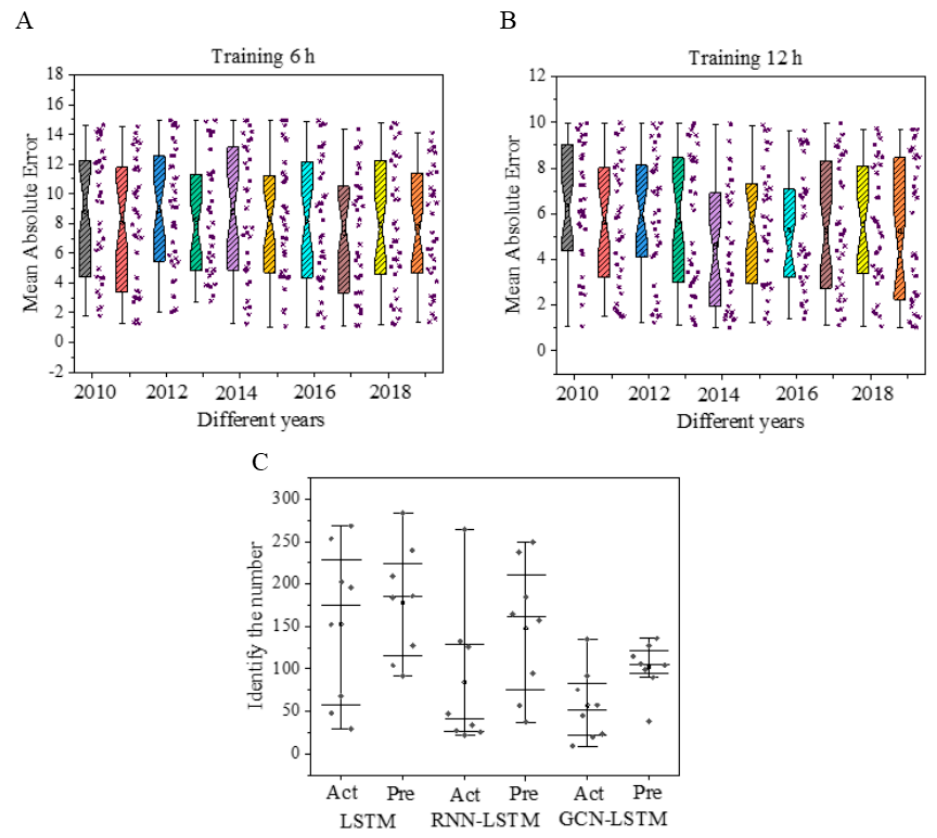
Figure 13. Model stability test results. Figure ( A , B ) illustrate the mean absolute errors of the GCN-LSTM model after 6 h and 12 h training on the data of 2010–2019, respectively. Figure ( C ) shows the identified and predicted number of typhoons of LSTM, RNN-LSTM, and GCN-LSTM models.